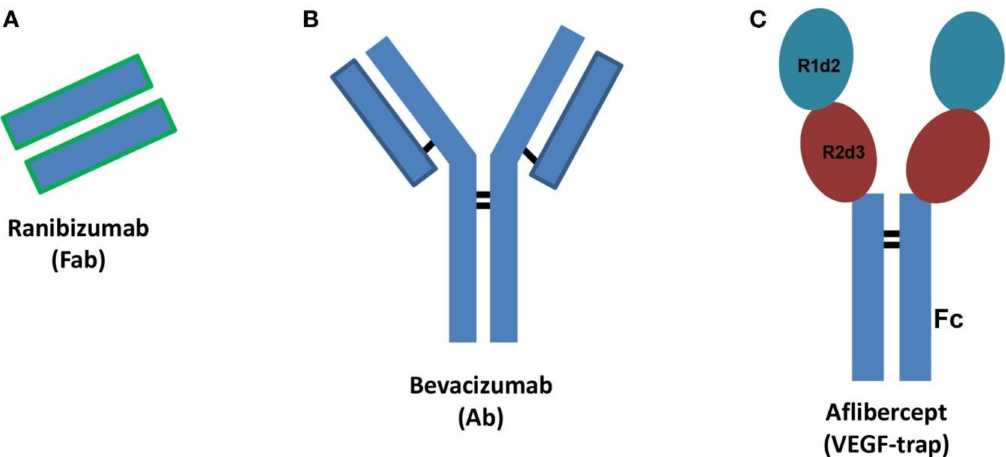
Figure 3. Schematic structures of ranibizumab ( A ), bevacizumab ( B ), and aflibercept ( C ). Ab: antibody, Fab: fragment antigen binding, Fc: fragment crystallizable region. R1d2: domain 2 of vascular endothelial growth factor receptor VEGFR1, R2d3: domain 3 of VEGFR2. Black bars: interchain disulfide bridges. From Platania et al. 2015